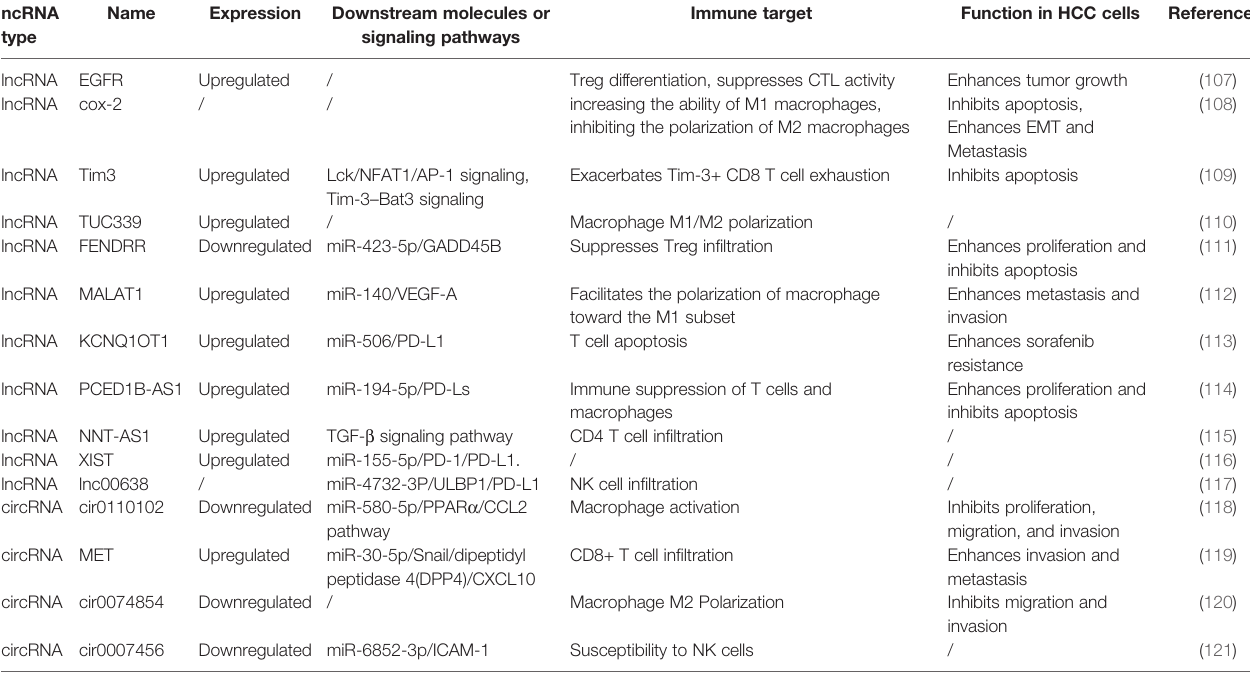
TABLE 5 | The abnormally expressed lncRNAs and cirRNAs involved in functional regulation of immune